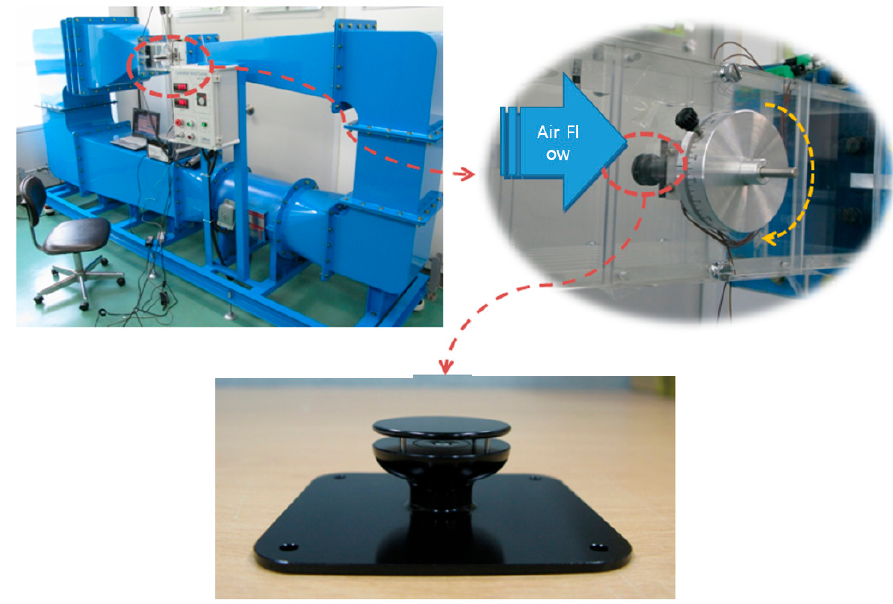
Figure 4. A wind tunnel for measuring the manufactured MEMS 2D wind direction and wind speed sensor.